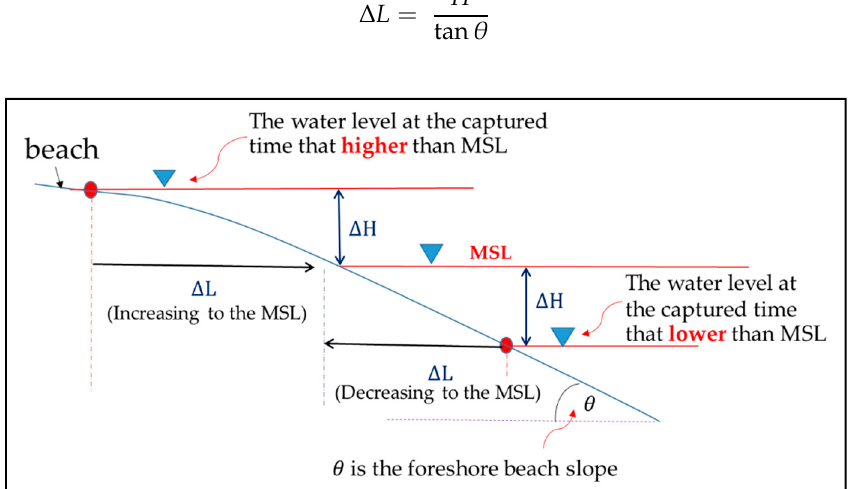
Figure 5. Beach profile of tidal correction method. Adapted from [11].